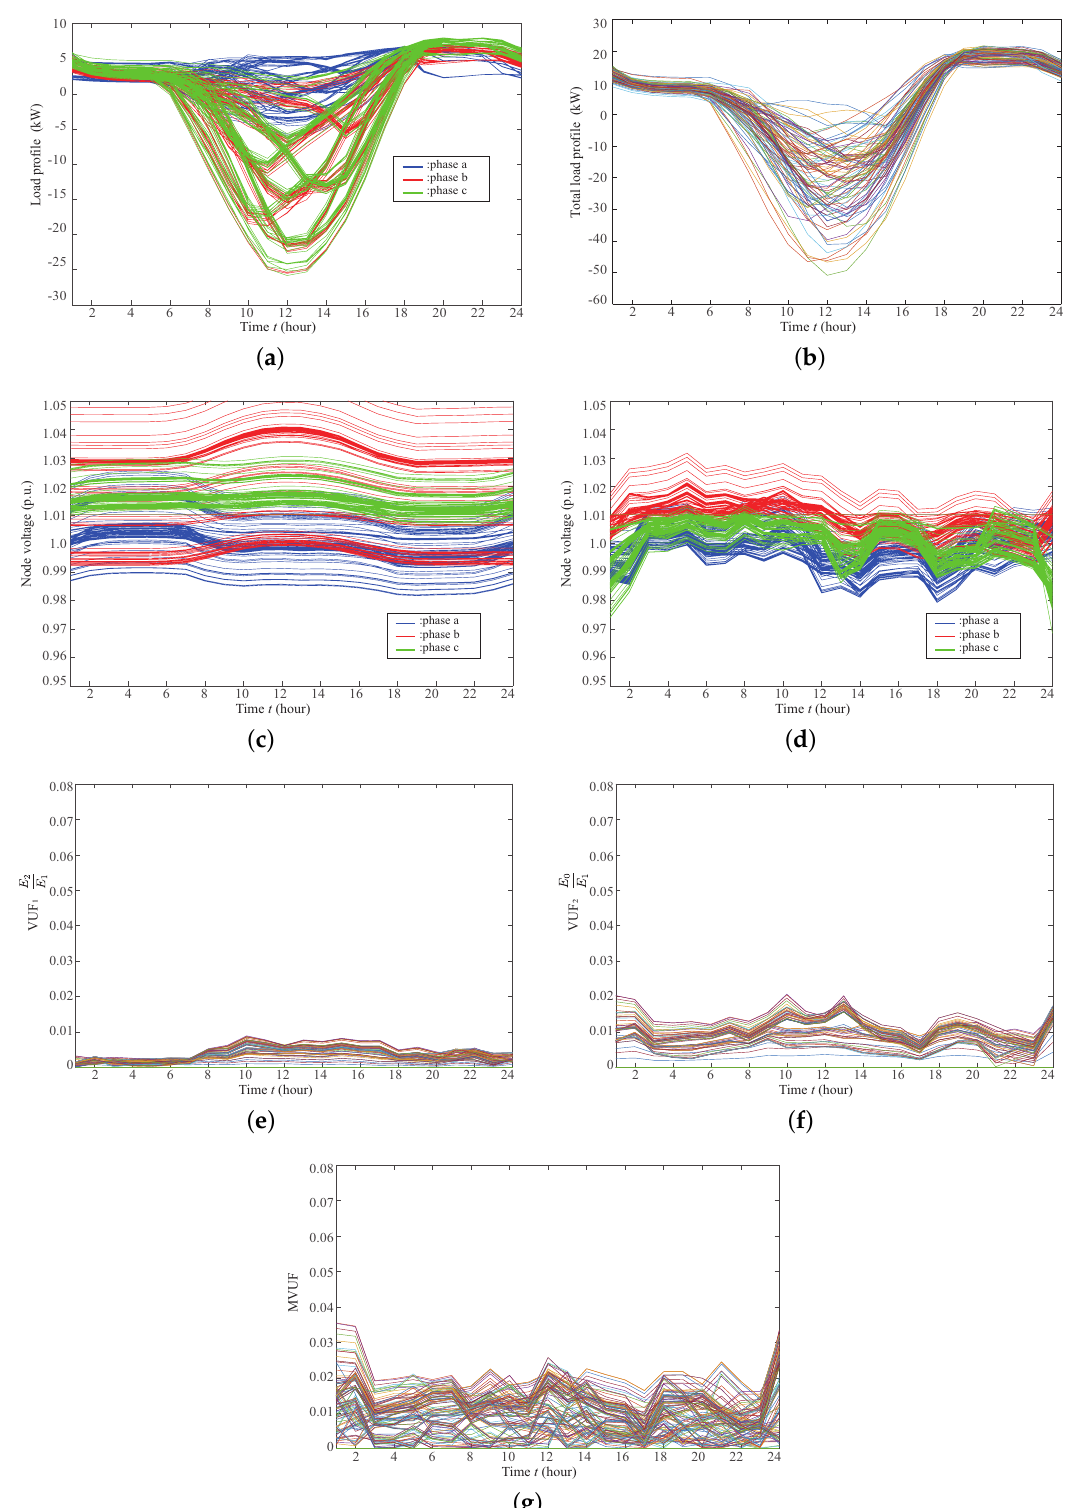
Figure 24. Simulation result of PQ control for unbalance compensation (proposed method): ( a ) load profile in each phase, ( b ) total load of node units, ( c ) voltage profile at before control, ( d ) voltage profile after compensation, ( e ) VUF 1 values, ( f ) VUF 2 values, and ( g ) MUVF values.